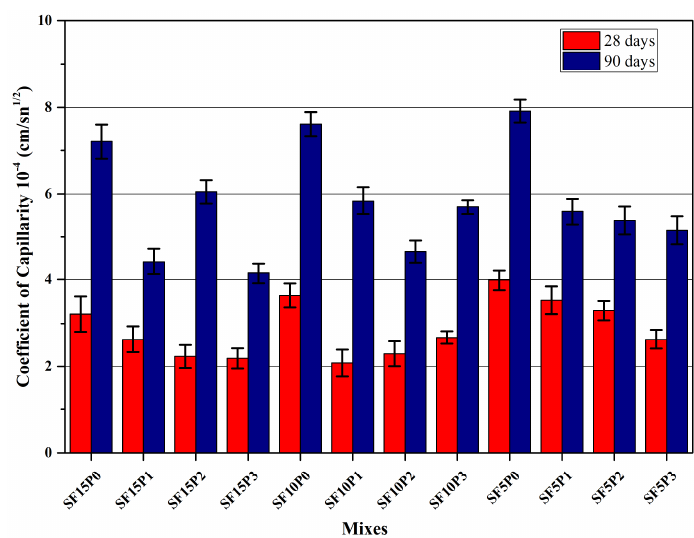
Figure 26. Capillary water absorption values of the SF samples